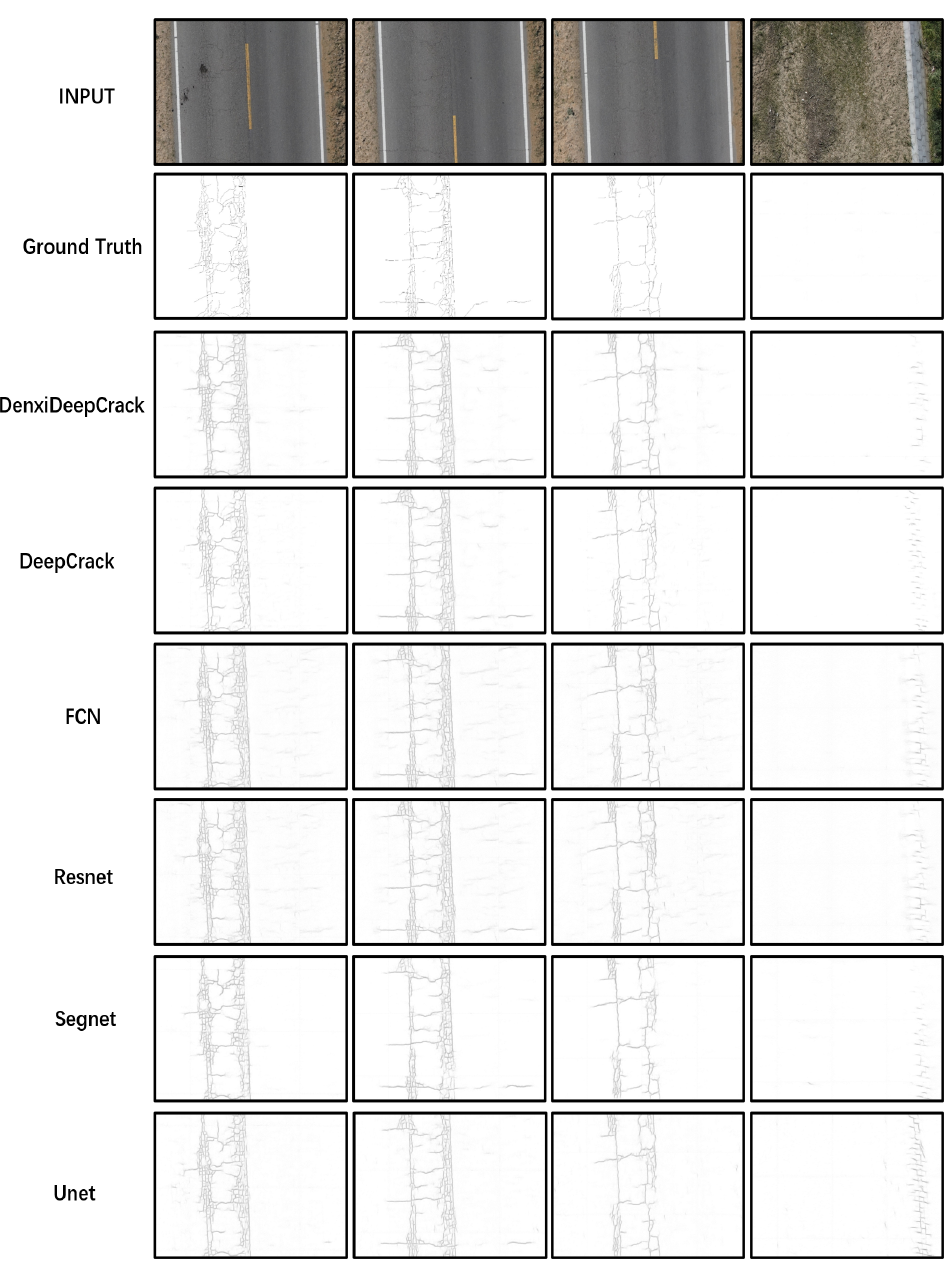
Figure 8. Results of the six algorithms on the